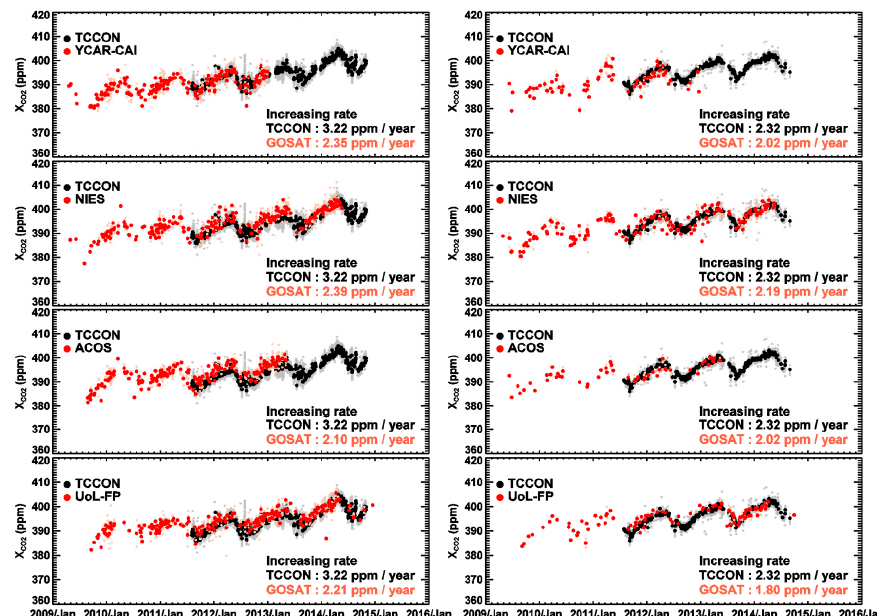
Figure 3. Time series of retrieved X CO2 from four GOSAT algorithms (YCAR-CAI, NIES, ACOS, and UoL, from top to bottom, respectively) and from two TCCON sites (Tsukuba (left) and Saga (right)). All TCCON retrieved data are shown in small gray dots and daily average TCCON X CO2 values within 1 h of GOSAT passing times (approximately 12:50 UTC at East Asia TCCON sites) are shown in large black dots.